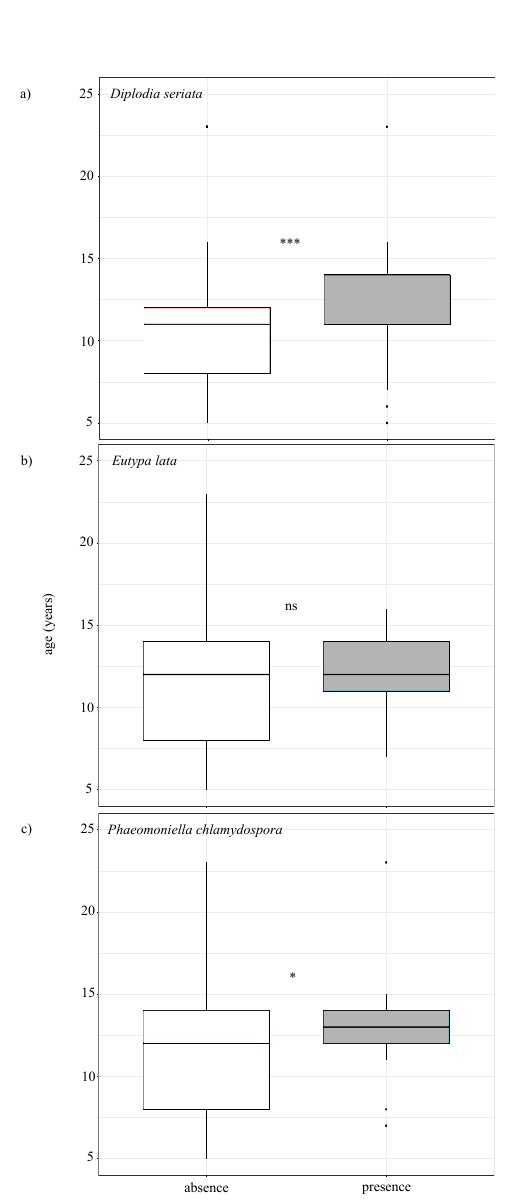
Figure 1. Effect of age of plants on the presence and absence of a) Diplodia seriata (*** P < 0.001) b) Eutypa lata (not significantly dif- ferent) and c) Phaeomoniella chlamydospora (* P < 0.05) .